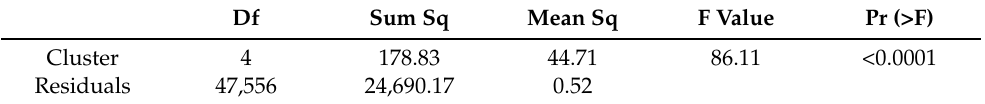
Table A3. A one-way ANOVA for comparing the means of RT scores for different clusters. Df Sum Sq Mean Sq F Value Pr (>F) Cluster 4